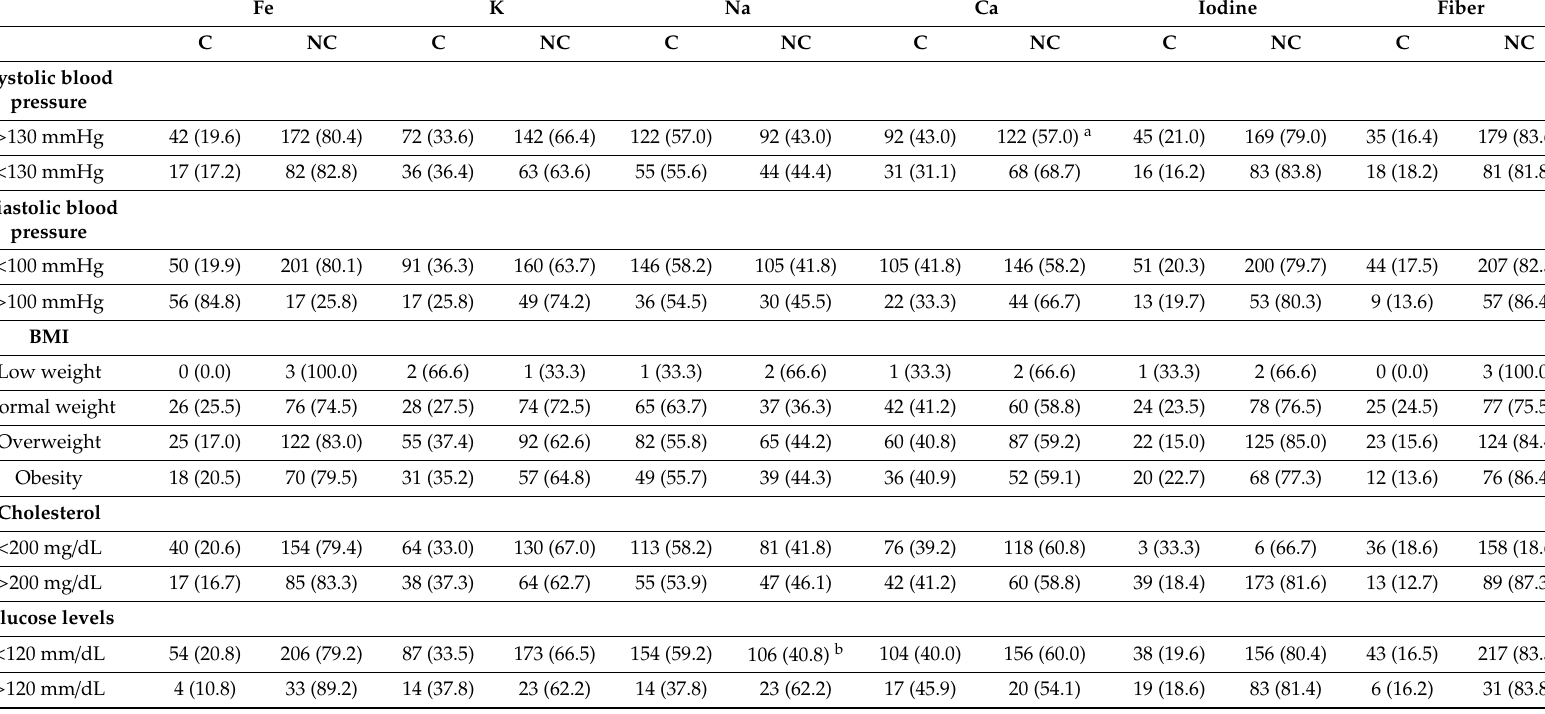
Table 9. Relationship between clinical variables and compliance with recommendations for mineral and fiber